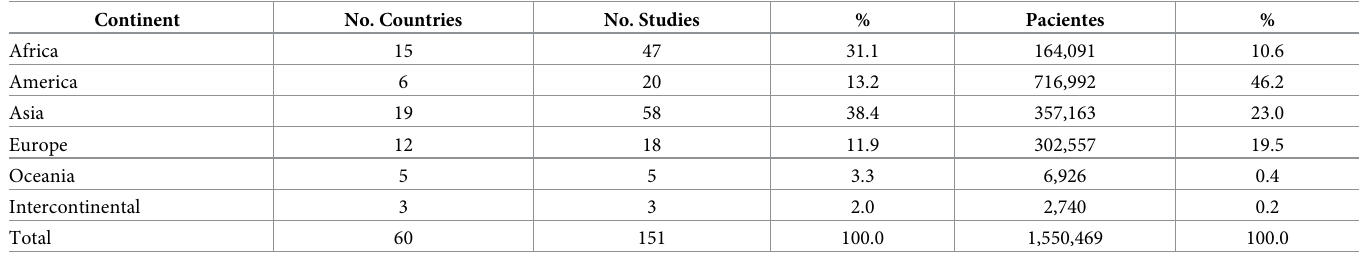
Table 1. Distribution of patients with TB in the